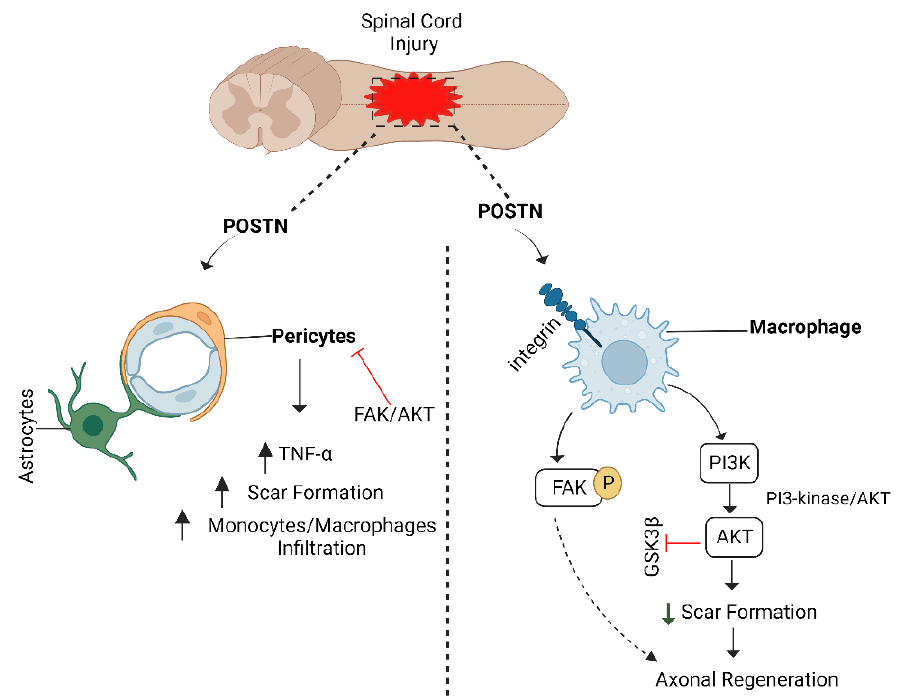
Figure 13. POSTN/integrin pathway. POSTN binds to pericytes and increases scar formation that hinders CNS neurons’ regeneration capacity. On the other side, POSTN binds to integrin receptors and activates PI3K/AKT and FAK signalling. AKT increases monocyte/macrophage migration at the injury site and prevents the formation of scars to increase axon regeneration in CNS neurons. POSTN: periostin; PI3K: phosphatidylinositol-3-kinase; AKT: protein kinase B; FAK: focal adhesion kinase; CNS: central nervous system.